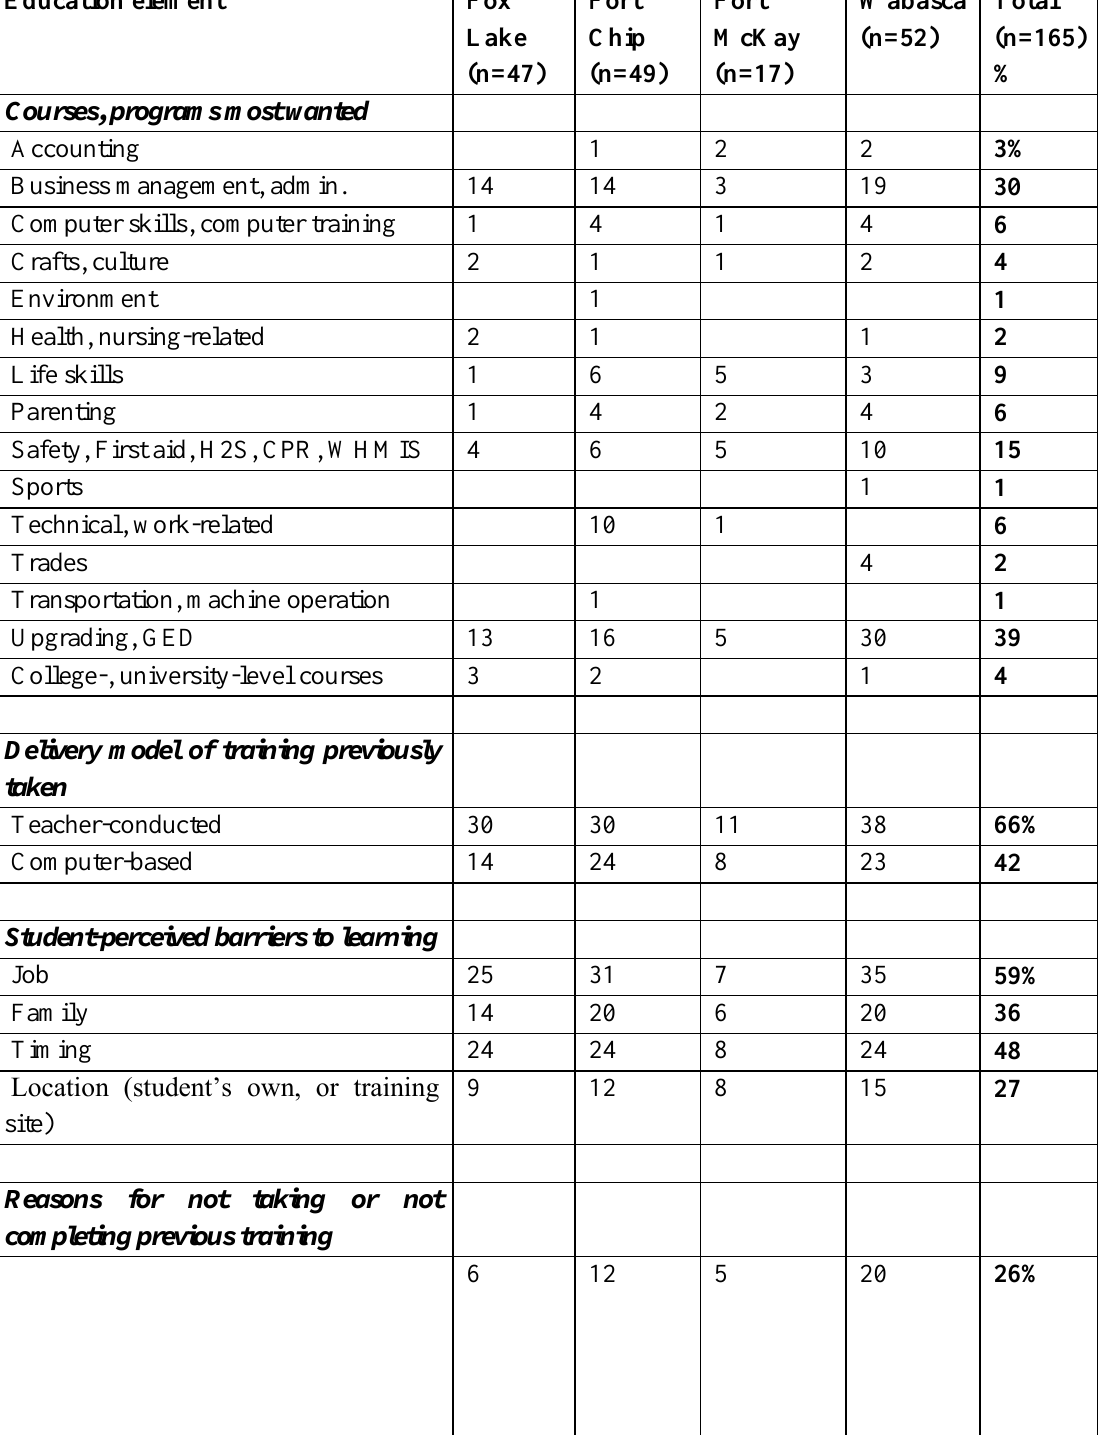
Table 3 Combined Results, Previous Education, Present Training Interests Education